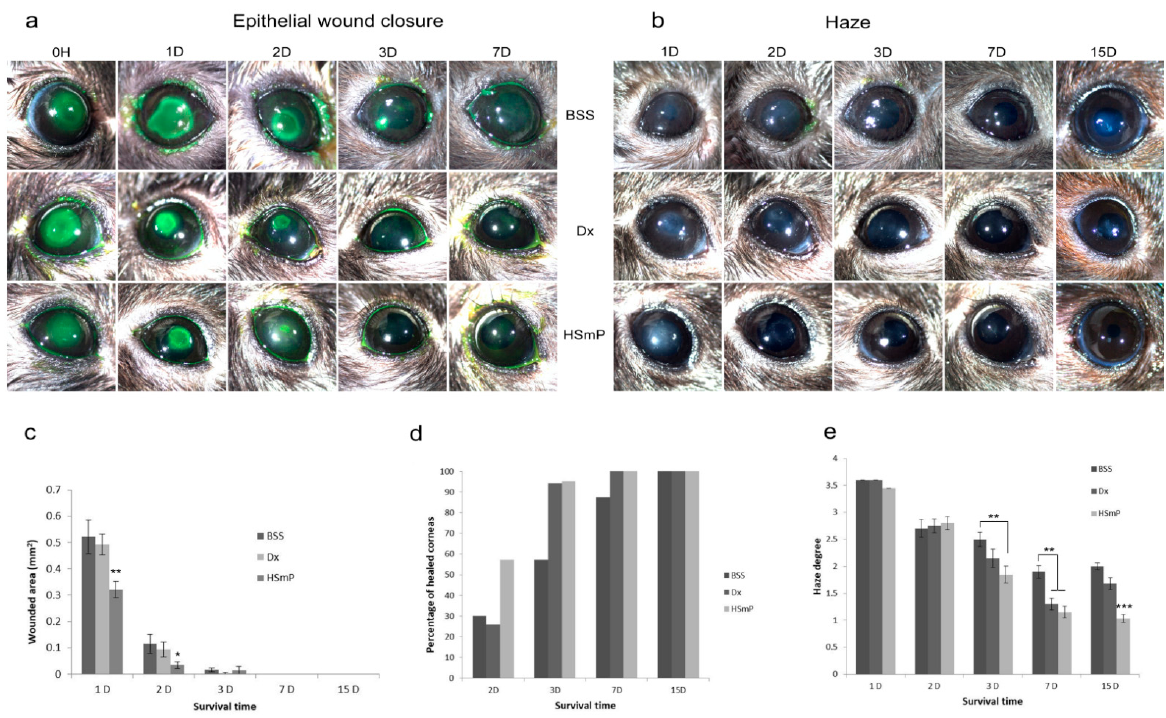
Figure 1. Macroscopic findings for the injured ocular surface. ( a ) The fluorescein-staining test demonstrated the epithelial defect in a temporal sequence. No fluorescein staining was recorded at 15 D. ( b ) The transparency of the cornea was reduced in the first two postsurgical days. The HSmP group showed transparent corneas at 15 D (magnification in ( a , b ): 12.5 × ). ( c ) Wound healing was had healed completely at 48 h. Some BSS treated eyes presented incomplete wound closure at day